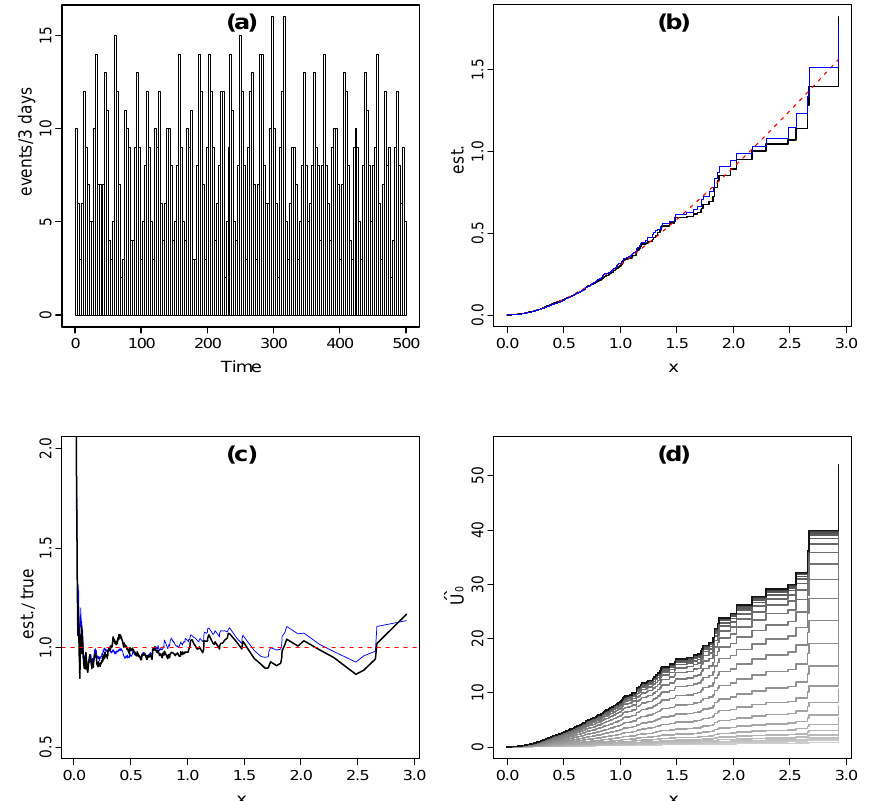
Figure 1. ( a ) Histogram of the simulated periodic gamma renewal process; ( b ) cumulative baseline intensity: ˆ U 0 (thick), A ( x ) (thin), and true (dashed); ( c ) ratio of ˆ U 0 (x) (thick) and A ( x ) (thin) to the true cumulative baseline intensity; ( d ) convergence steps of ˆ U 0 ( x ) . The iteration steps are indicated by different grayscales from the lightest gray for the initial step to the darkest for the final